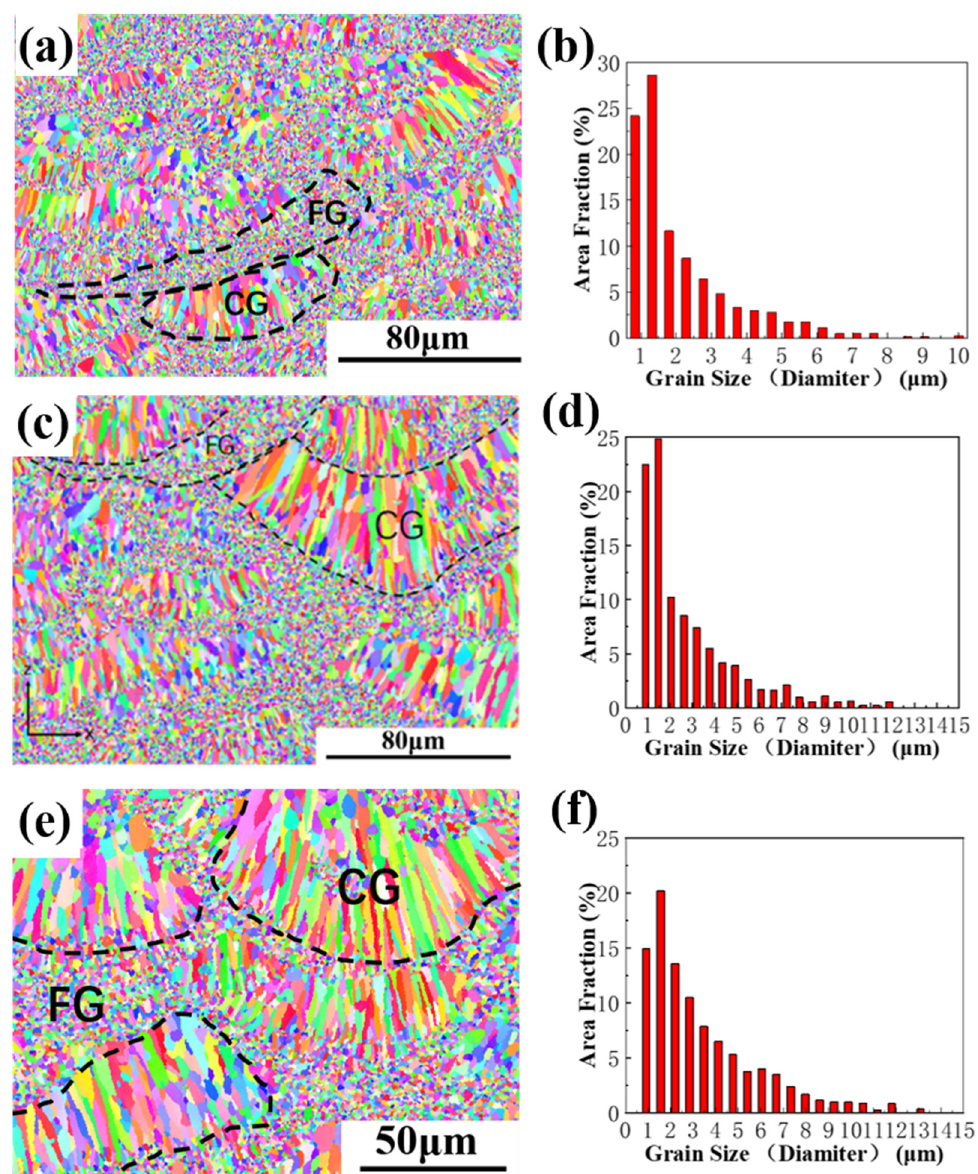
Figure 6. EBSD analysis and grain size distribution in vertical plane of SLM forming specimen ( a , b ) as-printed AlZnMgCu(Sc,Zr) alloy, ( c , d ) as-printed TiB2/AlZnMgCu(Sc,Zr) composite and ( e , f ) heat-treated TiB2/AlZnMgCu(Sc,Zr) composite. ( a , b ) as-printed AlZnMgCu(Sc,Zr) alloy, ( c , d ) as-printed TiB 2 /AlZnMgCu(Sc,Zr) composite and ( e , f ) heat-treated TiB 2 /AlZnMgCu(Sc,Zr)